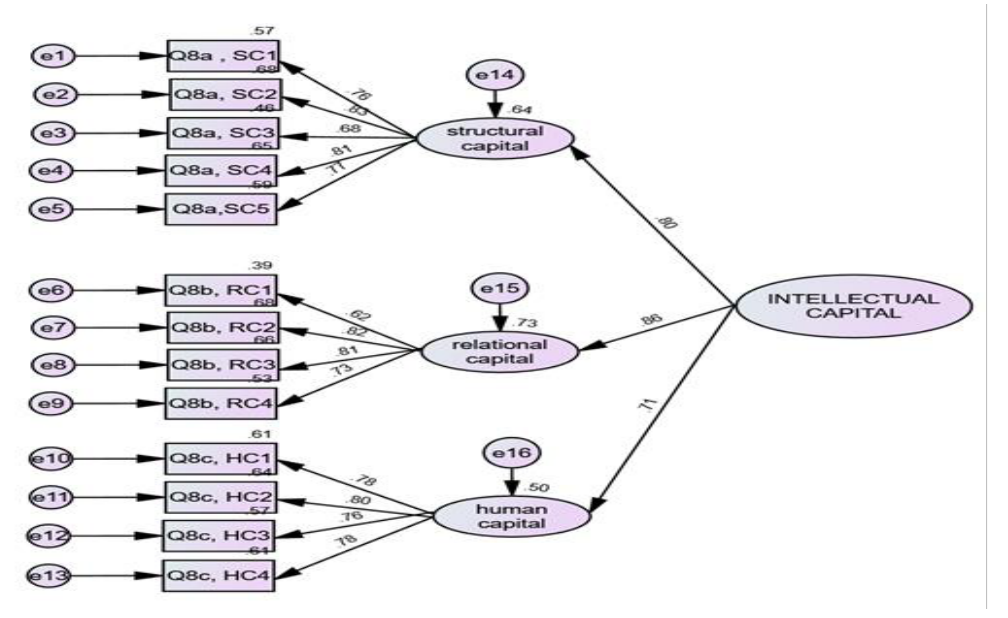
Fig. 1: Confirmatory factor analysis for intellectual